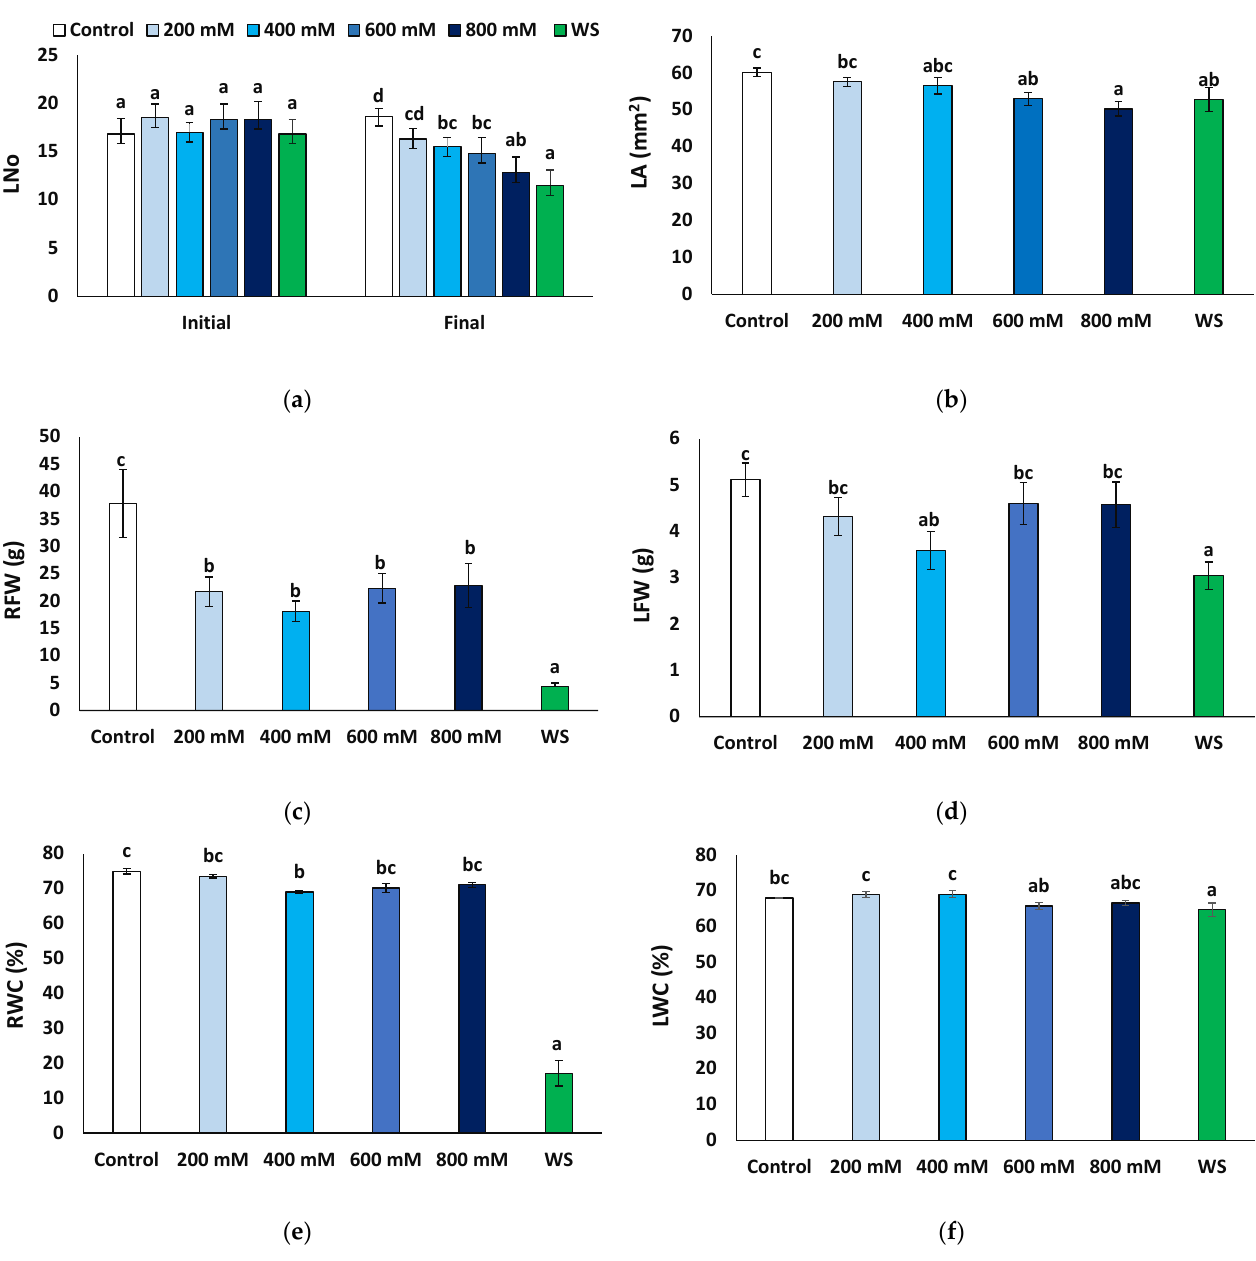
Figure 2. Growth parameters after four weeks of salt treatments with the indicated NaCl concentra- tions (X-axis), or one month of water stress (WS), of Limonium angustebracteatum plants. ( a ) Number of leaves, Lno, ( b ) leaf area, LA, ( c ), root fresh weight, RFW, ( d ), leaf fresh weight, LFW, ( e ) root water content, RWC, and ( f ) leaf water content, LWC. Means ± SE, n = 6. Different lowercase letters above the bars indicate significant differences between treatments, according to Tukey’s test ( α = 0.05).